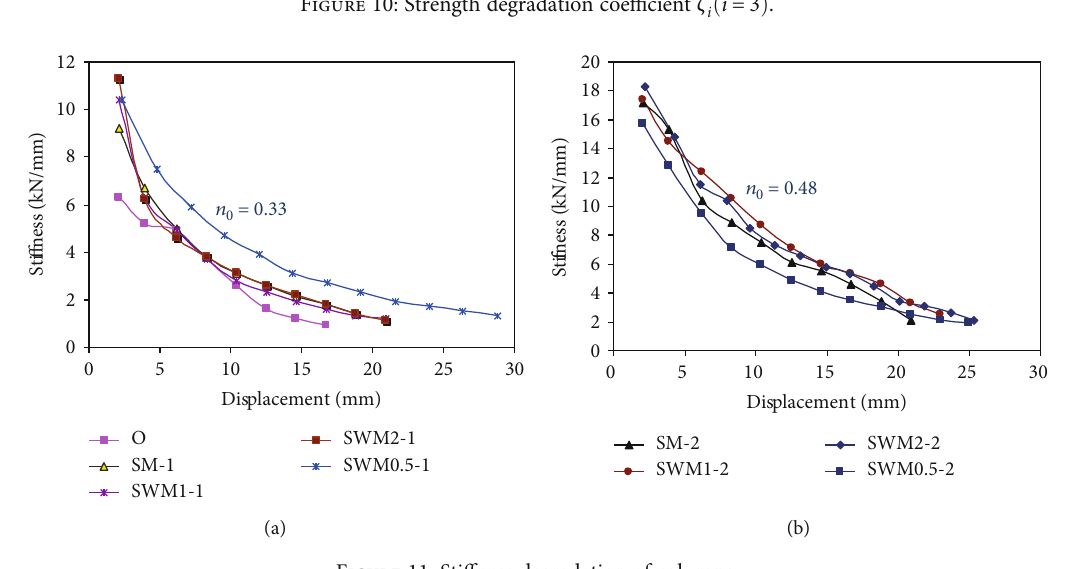
Figure 10: Strength degradation coe ffi cient ζ